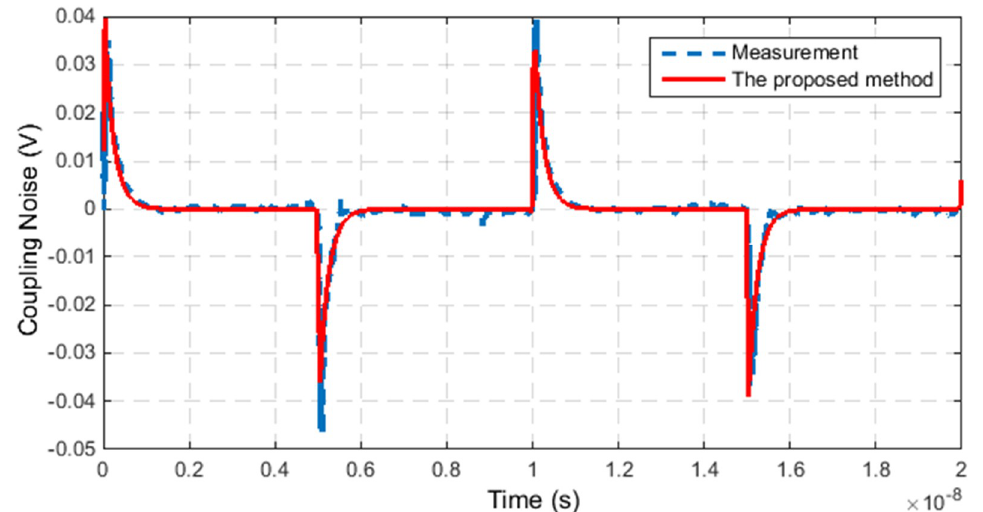
Figure 9. The proposed method and measured coupling of the TSV–TSV test vehicle (the input clock frequency is 100 MHz).